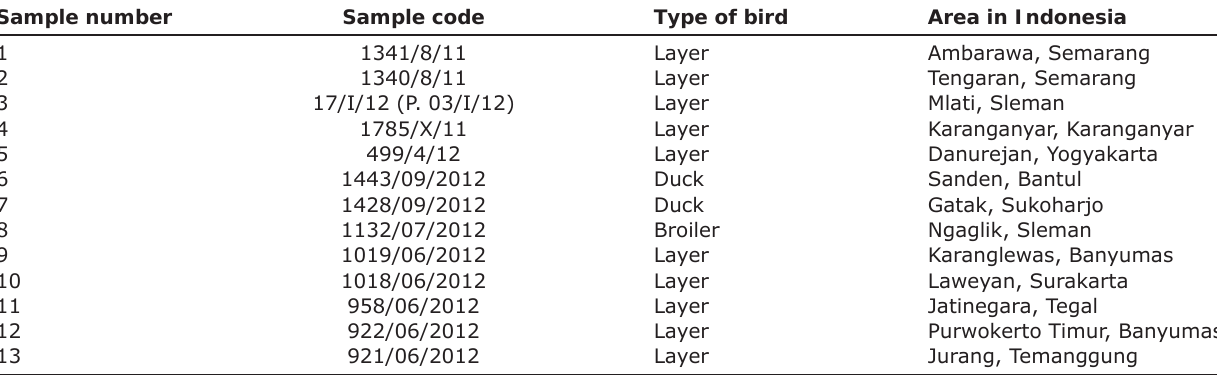
Table-1: The AEV isolates from field specimens which were collected from several district in Indonesia. Sample number Sample code